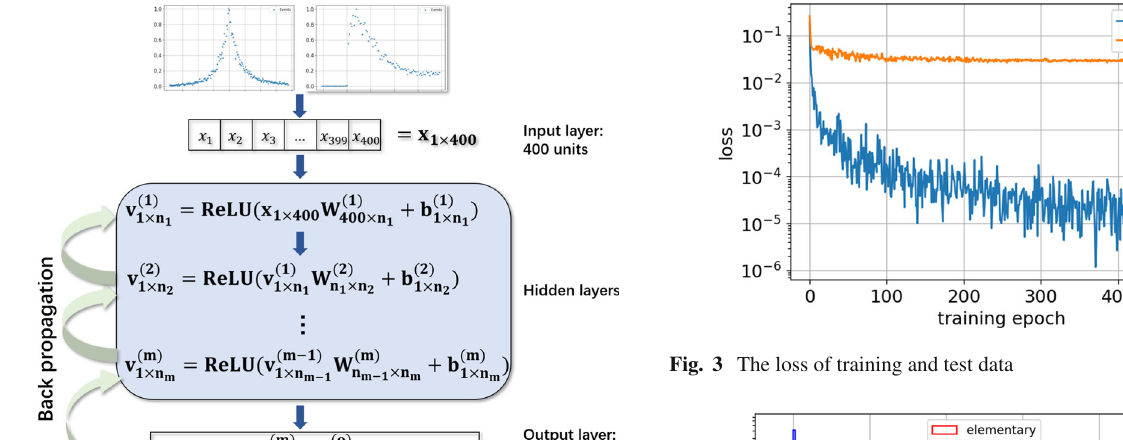
are constructed.